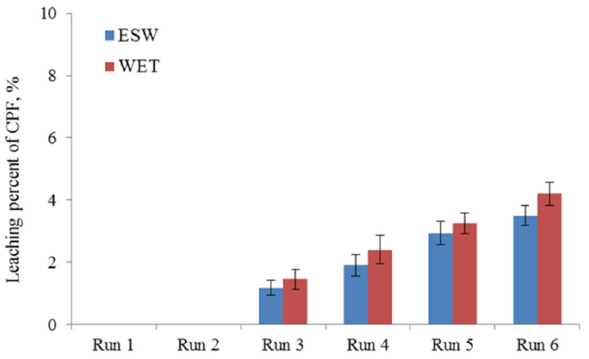
Figure 13. Percentage of leaching chlorpyrifos obtained from two sequential extraction tests: ESW and WET.